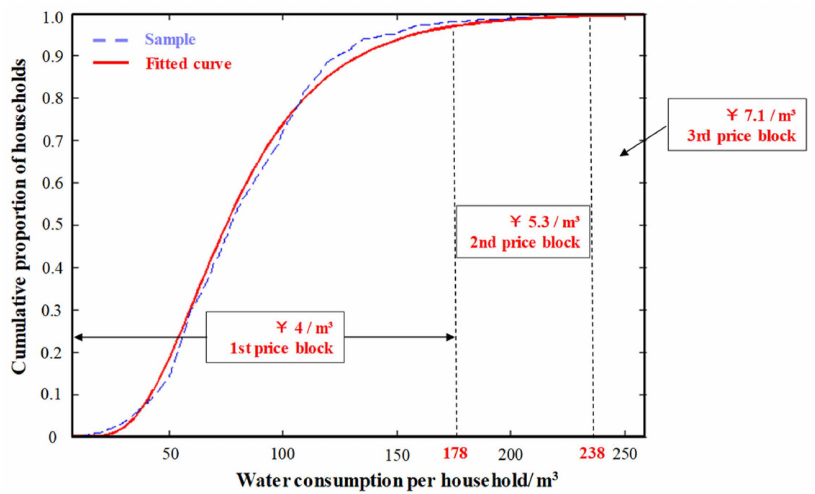
Figure 3. The distribution of residential water in Tianjin